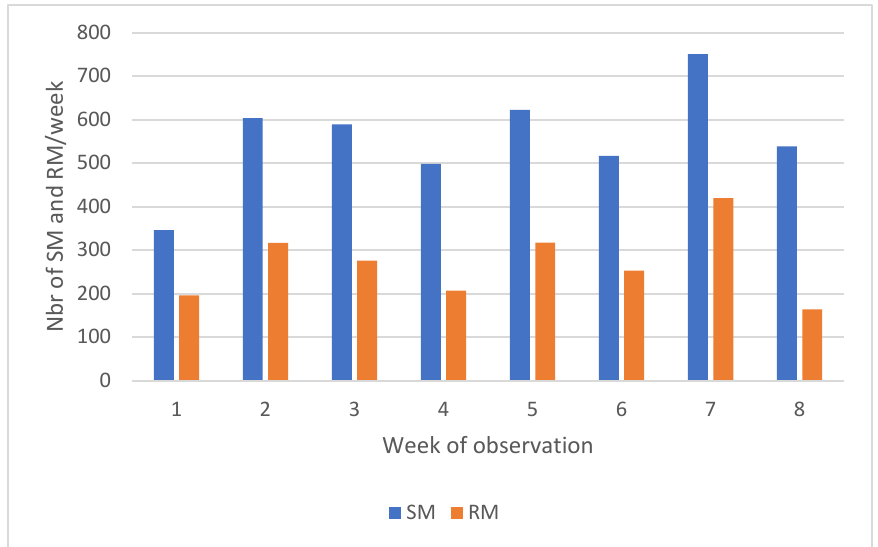
Figure 4. Relative occurrence of successful milkings (SM) and refused milkings (RM) over the weeks of observation.